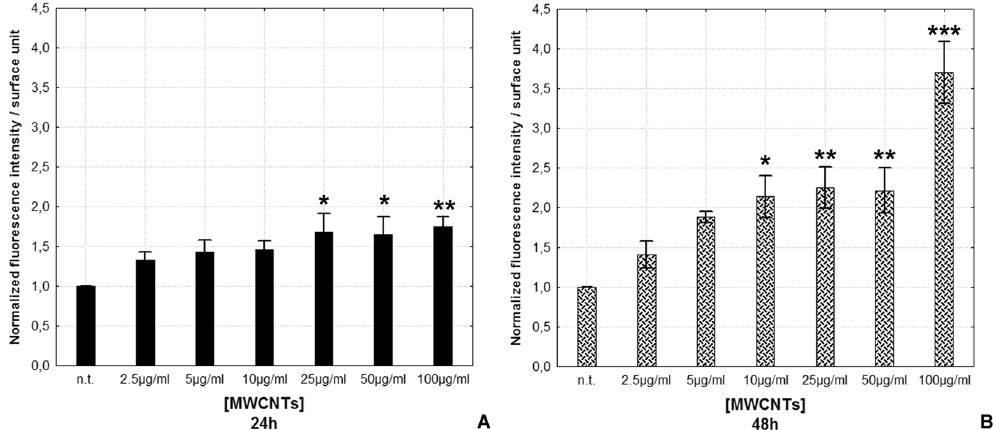
Figure 8. ROS production evaluation ( A , B ). Histograms showing H 2 DCFH-DA assay fluorescence intensity for surface unit after 24 h ( A ) and 48 h ( B ) MWCNT treatment. Statistical differences were calculated by Factorial ANOVA followed by Tukey’s post-hoc test, vertical bars denote standard deviation, * p < 0.05, ** p < 0.01, *** p < 0.001 (between n.t. and